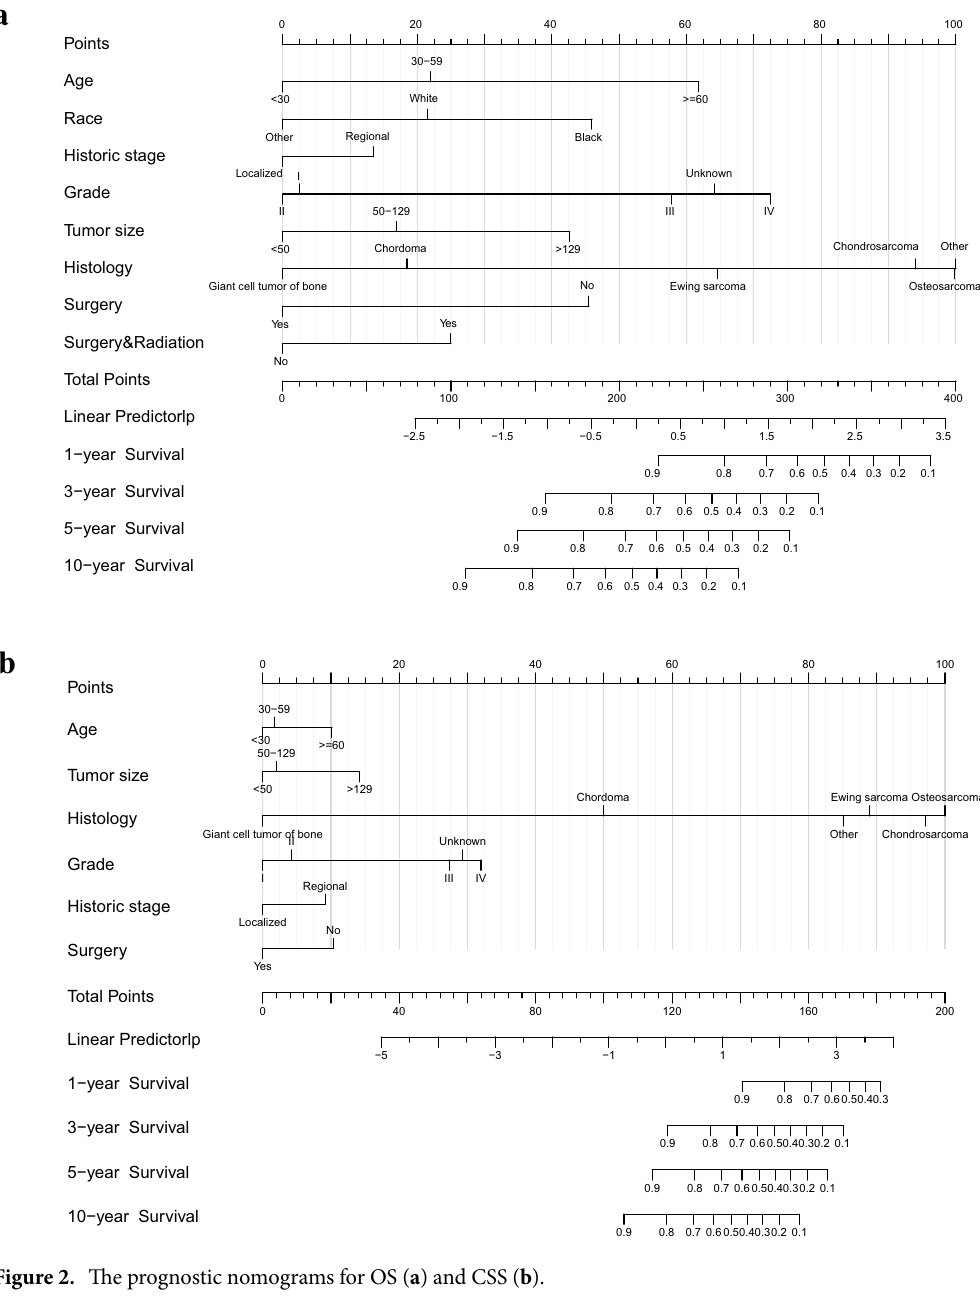
Figure 2. The prognostic nomograms for OS ( a ) and CSS ( b